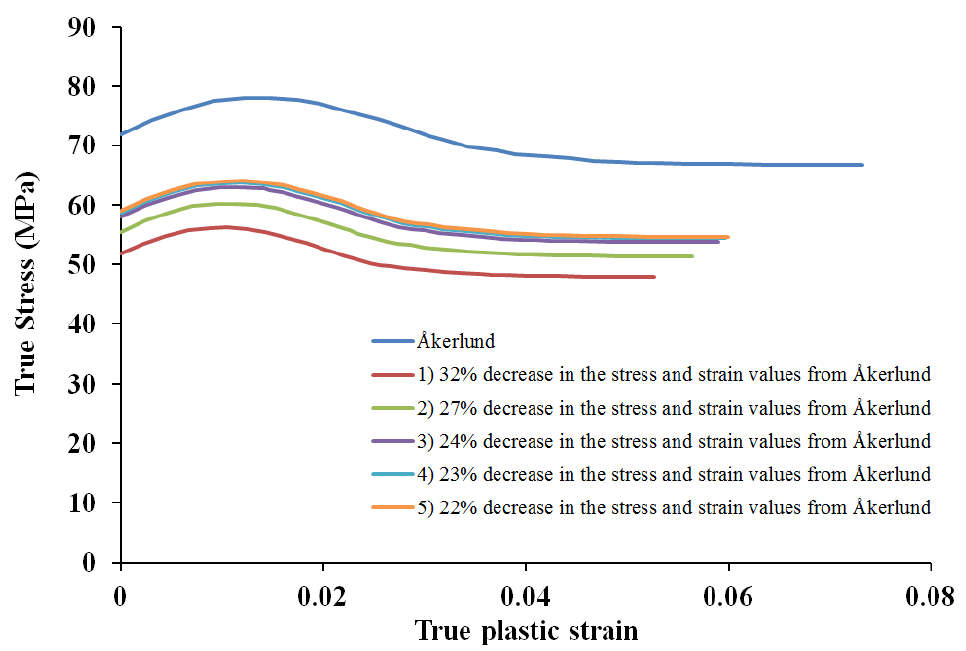
Figure 8. Compressive plastic stress – strain diagram [1].